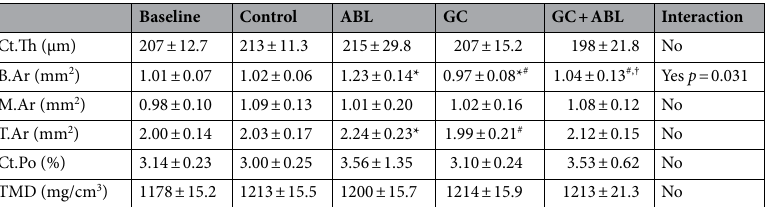
Table 2. Morphology of the right femoral mid-diaphysis of mice subjected to subcutaneous slow-release glucocorticoid (GC) pellets and treated with abaloparatide (ABL) for four weeks. Ct.Th cortical thickness, B.Ar bone area, M.Ar marrow area, T.Ar tissue area, Ct.Po cortical porosity, and TMD tissue mineral density. Mean ± SD. * p < 0.05 vs. Control. # p < 0.05 vs. ABL. † p < 0.05 vs. GC.